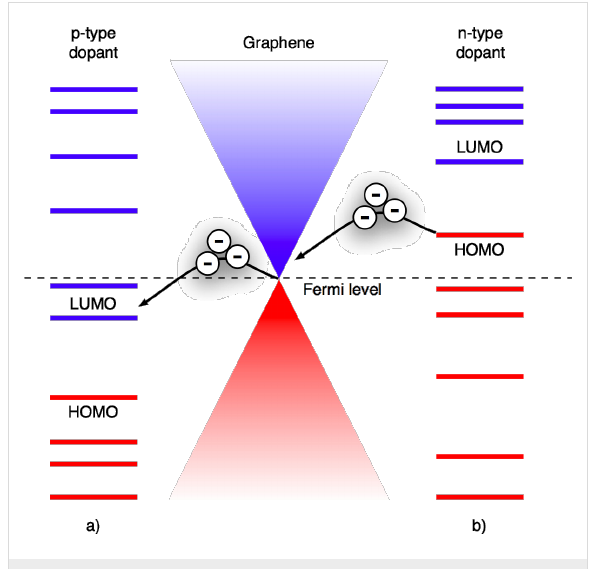
Figure 1: Scheme of the relative position of the highest occupied (HOMO) and lowest unoccupied (LUMO) molecular orbitals of an adsorbate to the Fermi level of graphene for a) p-type and b) n-type